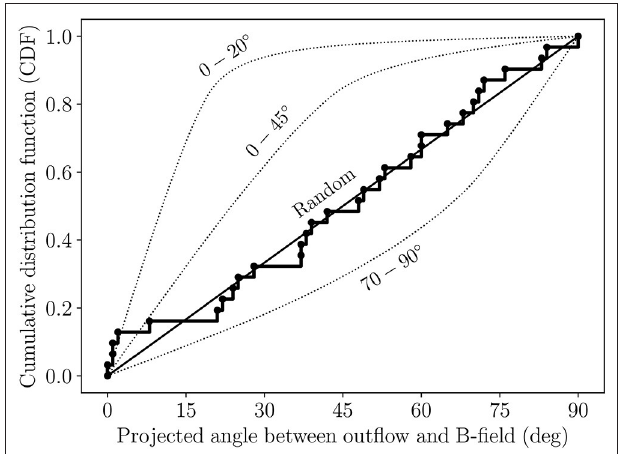
FIGURE 4 | The thick, stepped curve shows the cumulative distribution function (CDF) of the (projected) angles between the bipolar outflows and the mean magnetic-field orientations in the full sample of low-mass protostellar cores observed to date in full polarization with BIMA, the SMA, CARMA, and ALMA. The dotted curves are the CDFs from Monte Carlo simulations where the magnetic fields and outflows are oriented within 20, 45, and 70–90 ◦ of one another, respectively. The straight line is the CDF for random orientation. The plot shows that outflows appear to be randomly aligned with magnetic fields in the sample of low-mass sources whose magnetic fields have been observed with 500–1,000au ∼